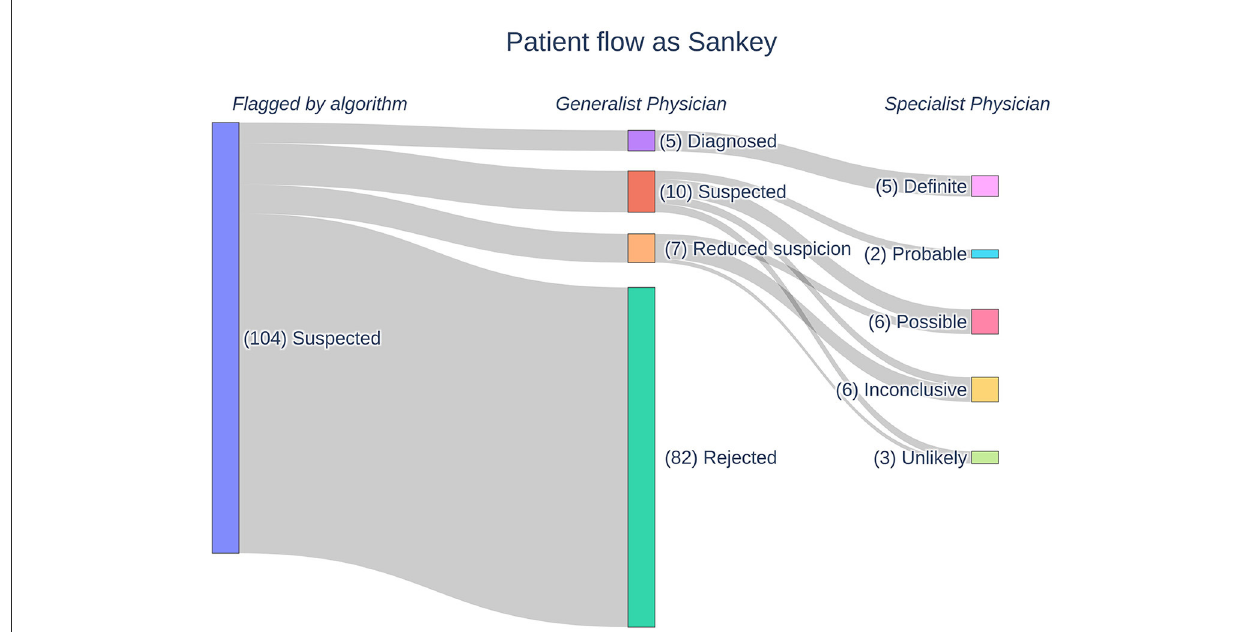
FIGURE1 A Sankey diagram outlining the flow of patients in our Pompe disease process funnel. Patients are flagged by our AI following which they undergo manual medical reviews by generalist and specialist physicians. The physicians assign labels to the patients according to their respective likelihoods for Pompe